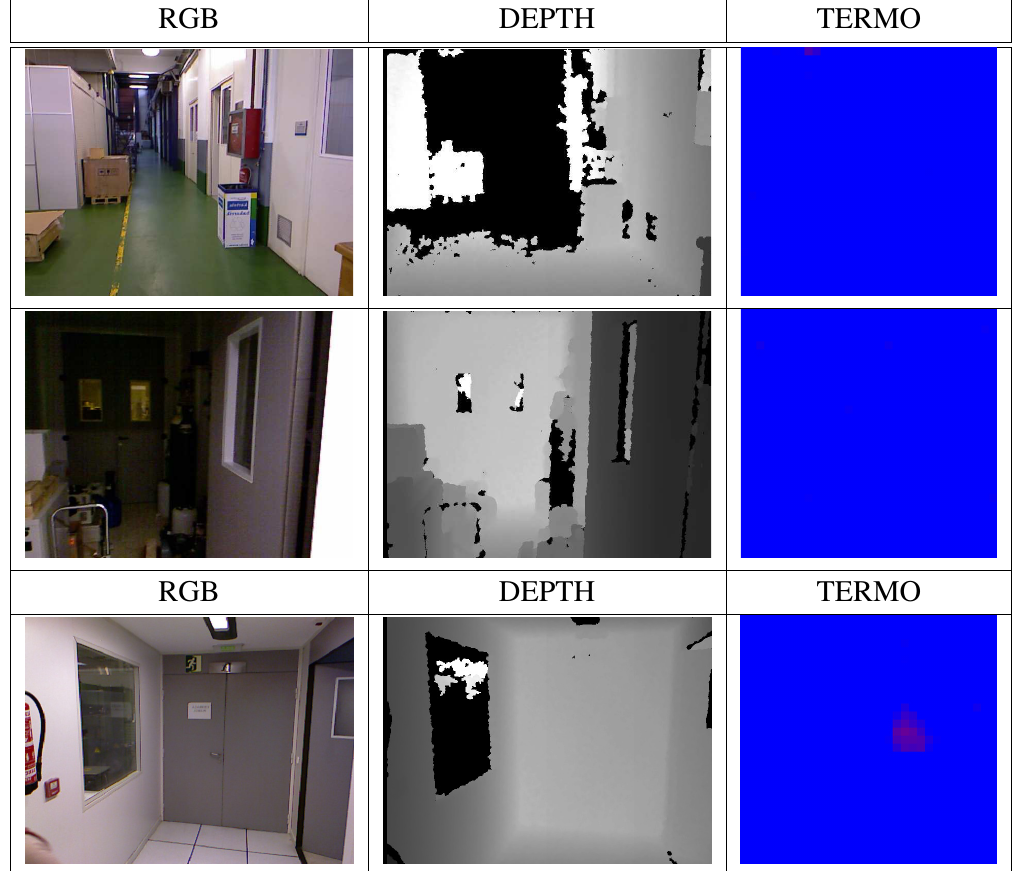
Figure 9. Negative examples in the three data sources (intensity, depth, thermal), with different elements in the